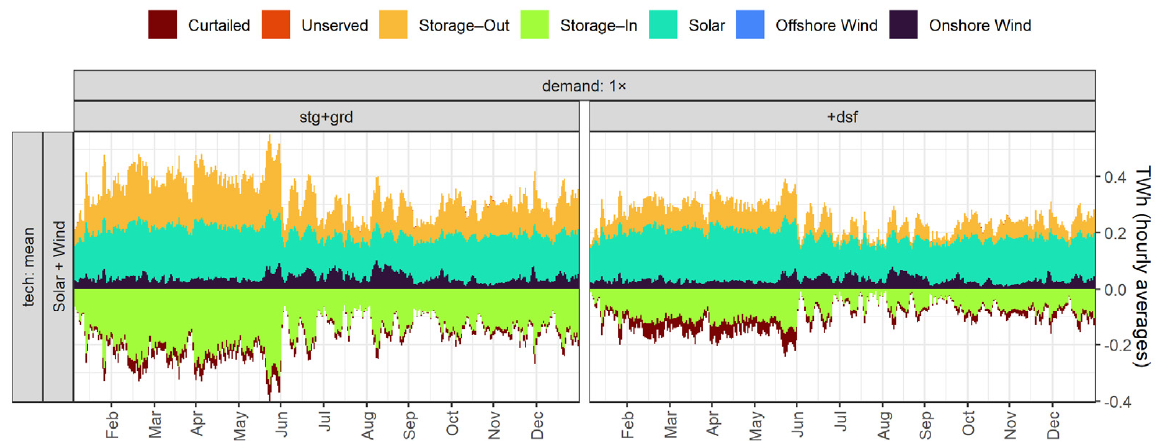
Figure 9. Annual operation profile by day, national aggregation, 2020 weather year.